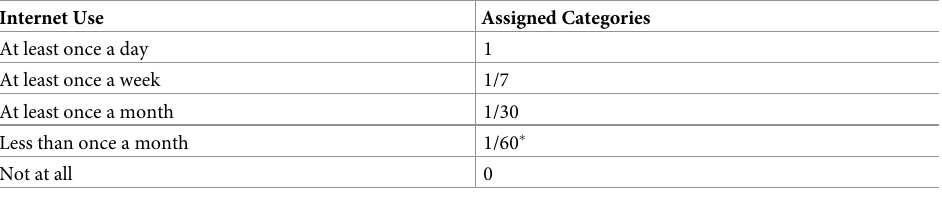
Table 3. Internet use before and after preprocessing.